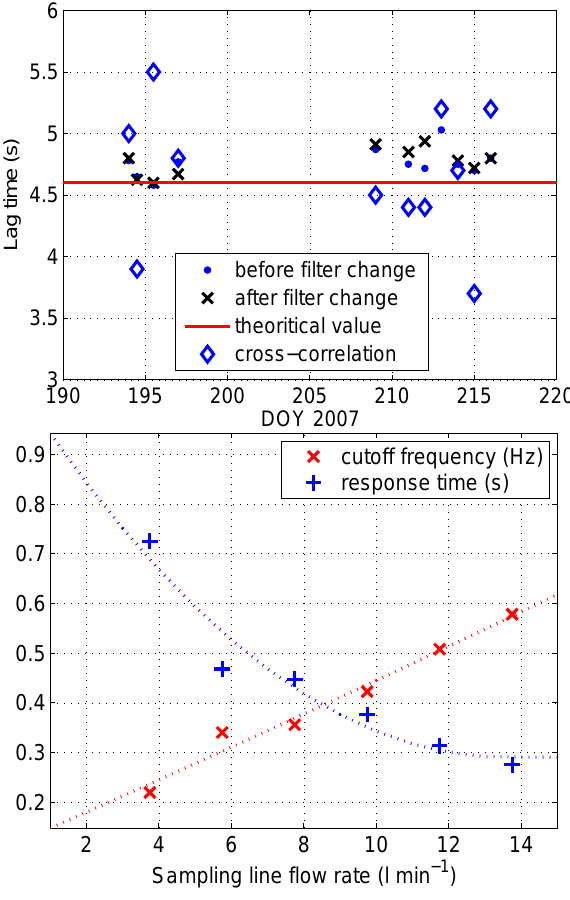
Fig. 7. Puff test results obtained during GOMECC-2007. The top panel shows the determined lag times from daily puff tests before and after filter changes, lag time results from the cross correlation method, and the theoretical lag time from consideration of the man- ifold volume and purge rate. The lower panel shows the response time of the instrument and cutoff frequency as a function of the total (line purge, reaction chamber, plus UV monitor) sampling line flow